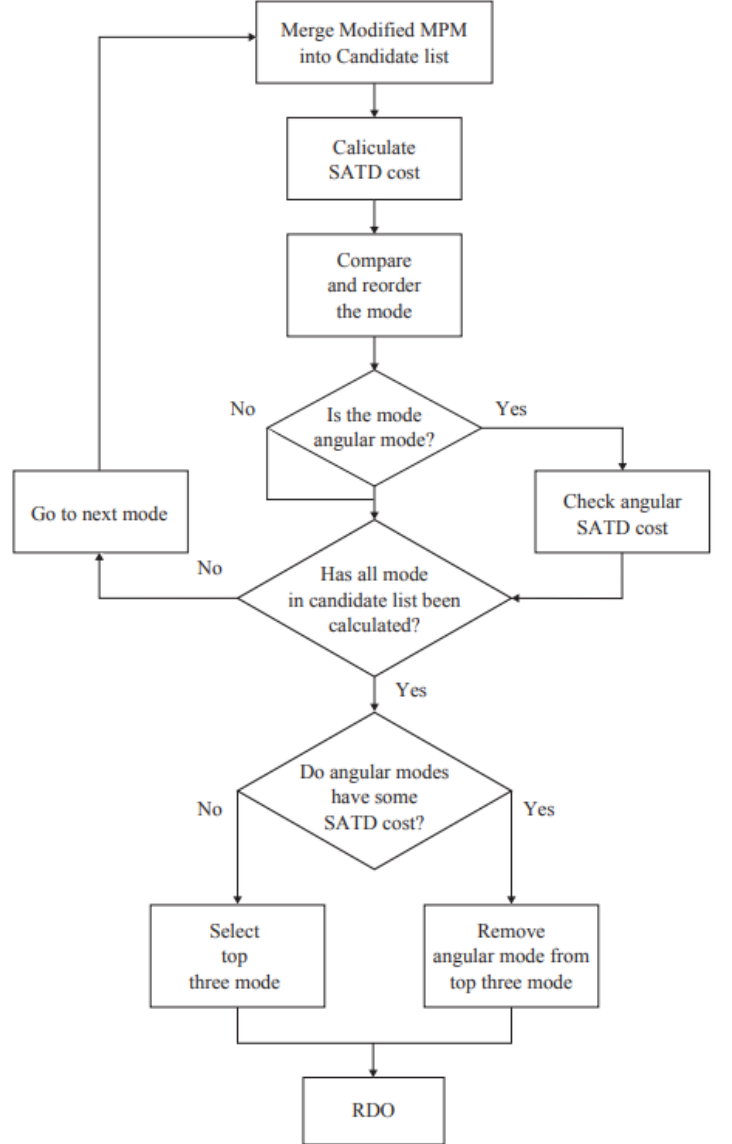
Figure 9. Algorithm for mode ordering and SATD